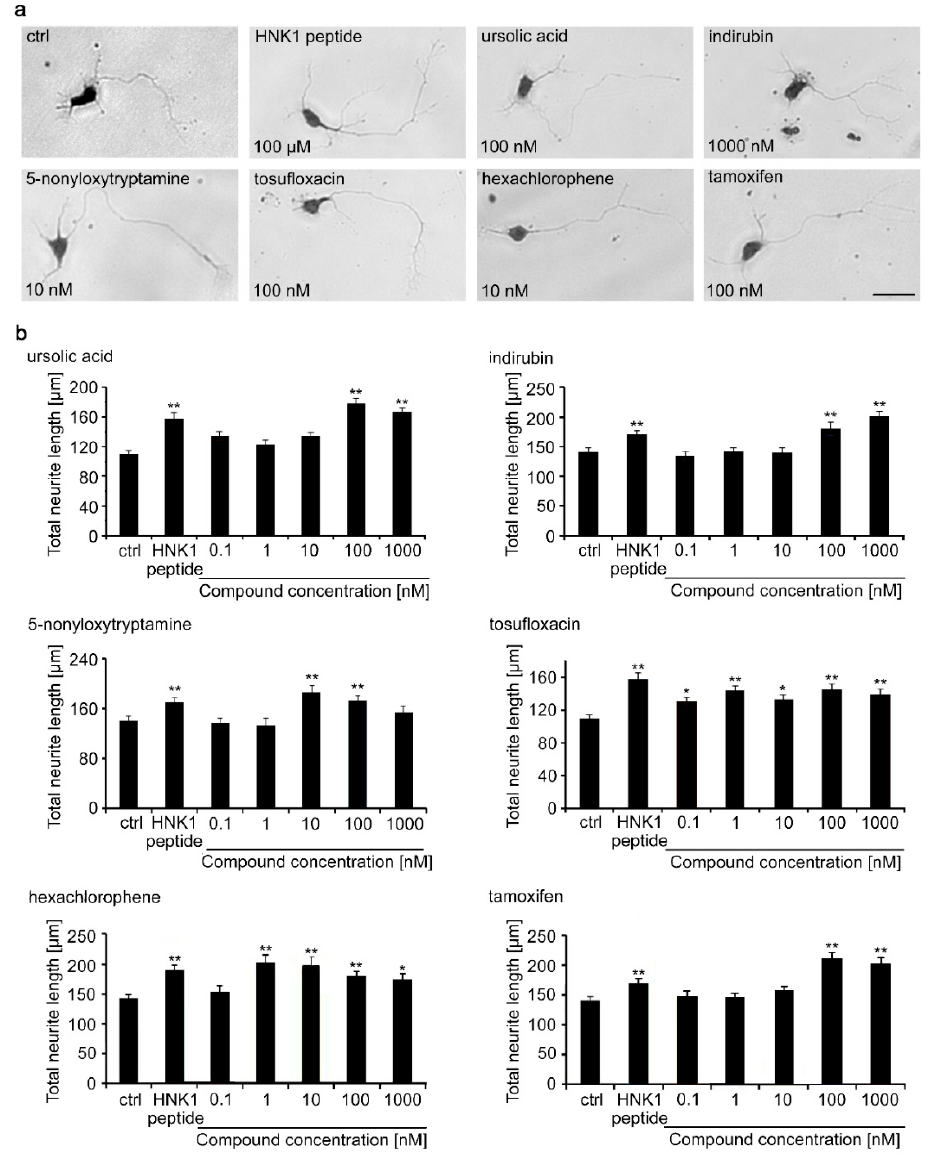
Figure 2. Neurite length of motor neurons treated with di ff erent concentrations of HNK1 mimetics as measured by ImageJ analysis. Cultures of motor neurons were treated for 24 h with di ff erent concentrations of mimetics and assayed by manual ImageJ analysis. The HNK1 mimetic peptide (100 µ M) served as positive control and 0.2% dimethyl sulfoxide (DMSO) was the vehicle control (ctrl). Neurons were fixed and stained with toluidine and methylene blue. ( a ) Representative images show brightfield images of motor neurons that were used to manually measure neurite lengths. Scale bar, 50 µ m. ( b ) Bar diagrams show the average total neurite length per neuron ( n = 300 neurons from three independent experiments + SEM). Asterisks indicate di ff erences in neurite length between HNK1 mimetics and the vehicle control (one-way ANOVA; Fisher’s PLSD test, * p < 0.05, ** p < 0.01).